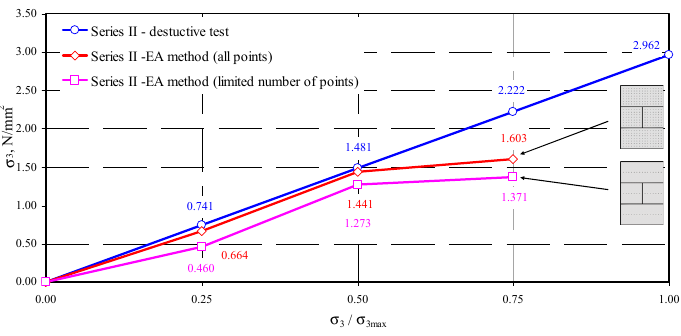
Figure 15. Measurement results of stress in the model II-1.